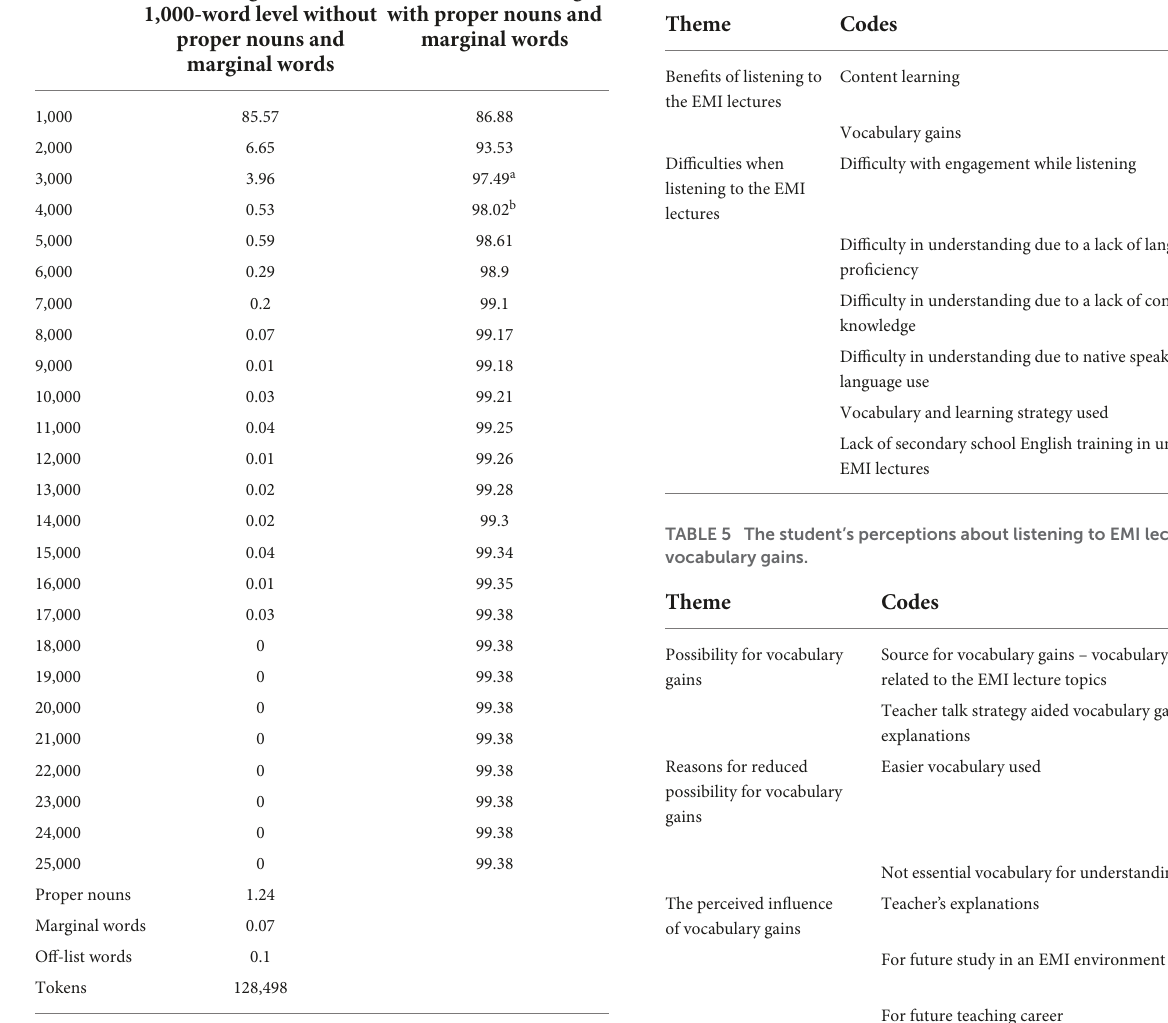
TABLE 3 Lexical coverage for the entire present corpus (%) with proper nouns and marginal